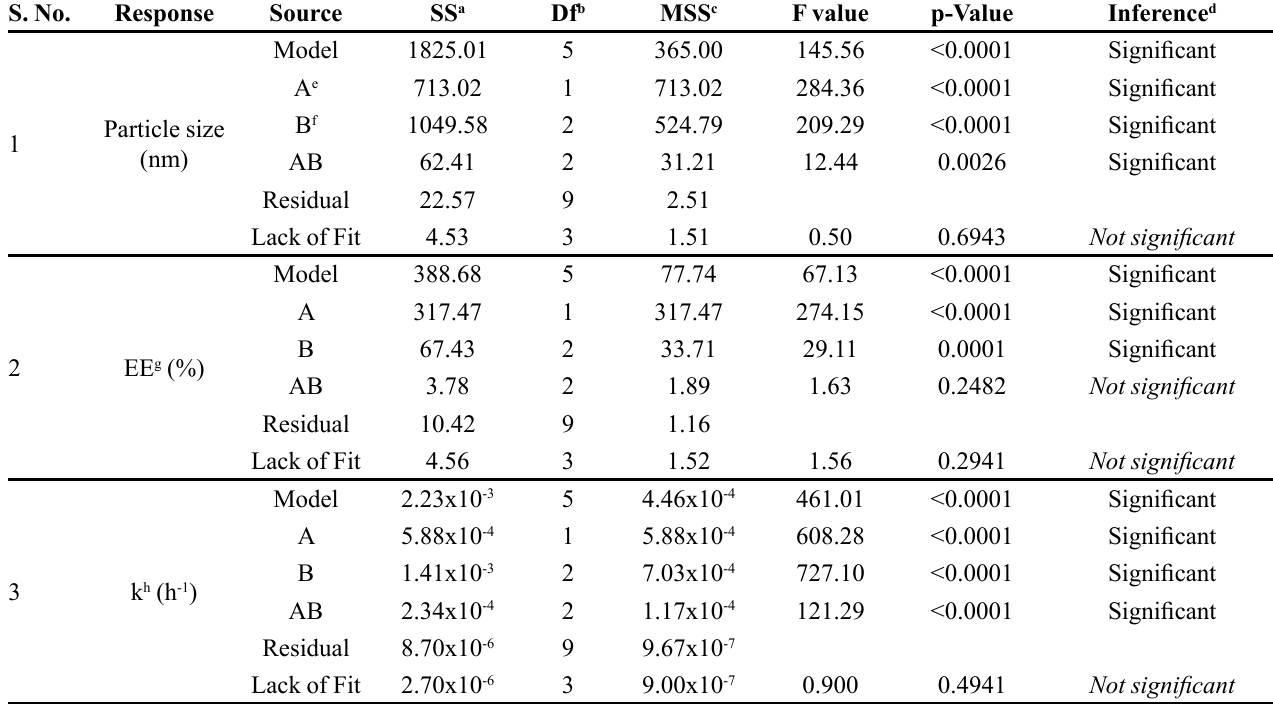
TABLE II - Results of ANOVA for response surface 2-factorial interaction model for the responses S.